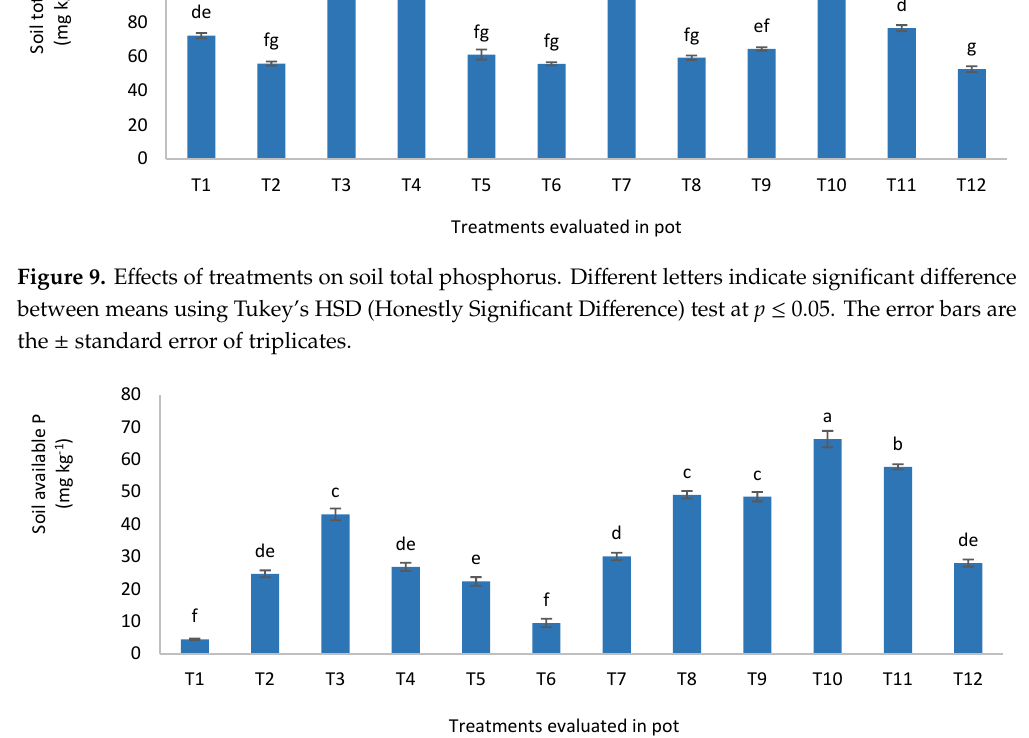
Figure 10. E ff ects of treatments on soil available phosphorus. Di ff erent letters indicate significant Figure 10. Effects of treatments on soil available phosphorus. Different letters indicate significant di ff erence between means using Tukey’s HSD (Honestly Significant Di ff erence) test at p ≤ 0.05. The difference between means using Tukey’s HSD (Honestly Significant Difference) test at p ≤ 0.05. The error bars are the ± standard error of error bars are the ± standard error of triplicates.